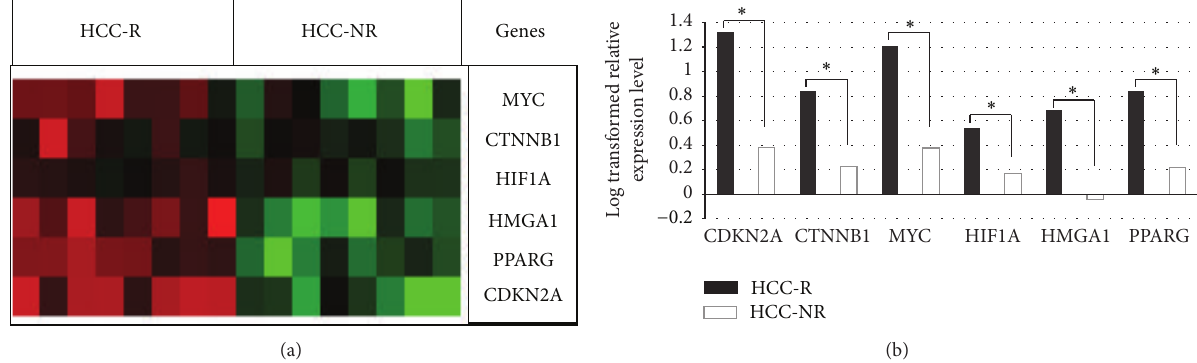
Figure 5: Validation of microarray data by qPCR. The 𝑃 values were calculated with Student’s 𝑡 -test ( ∗ 𝑃 < 0.05 ).